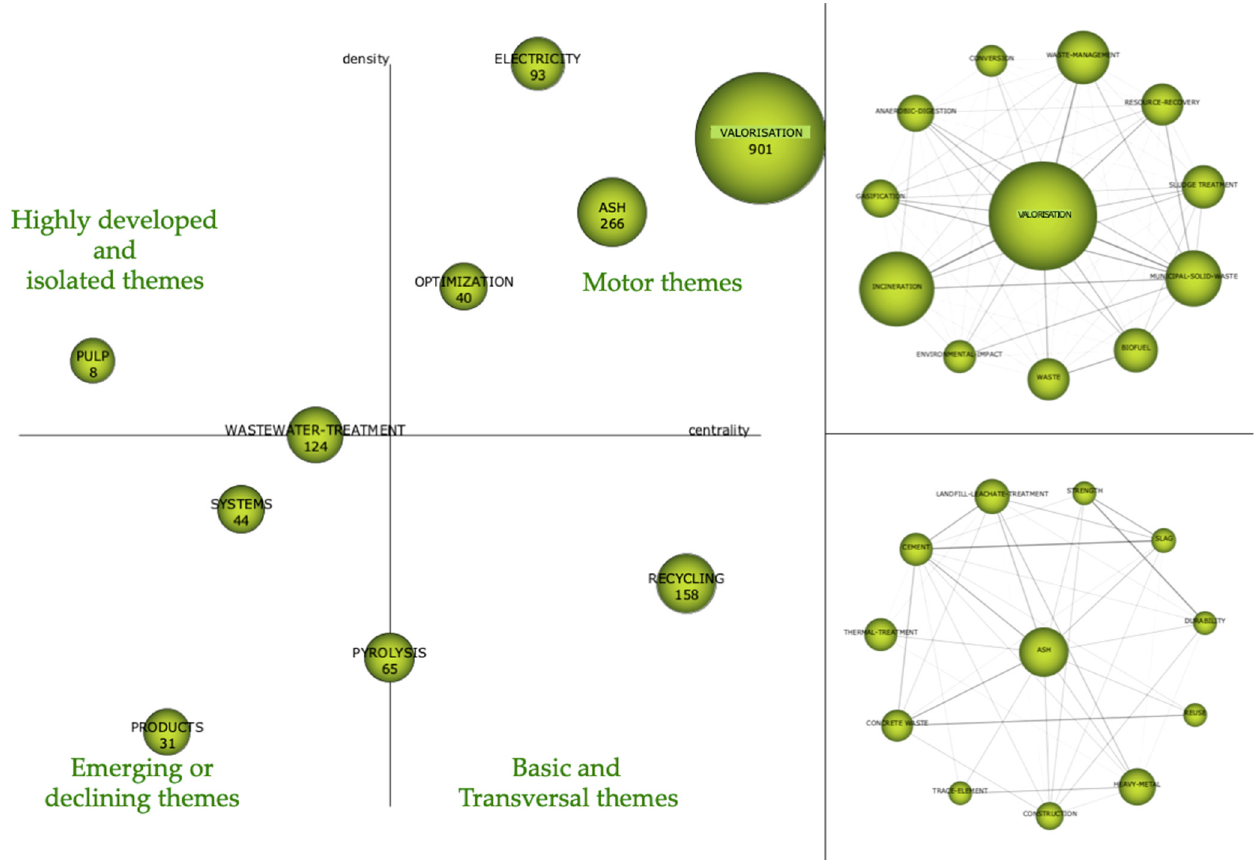
Figure 11. Strategic diagram and main thematic network, 2016–2021 period.